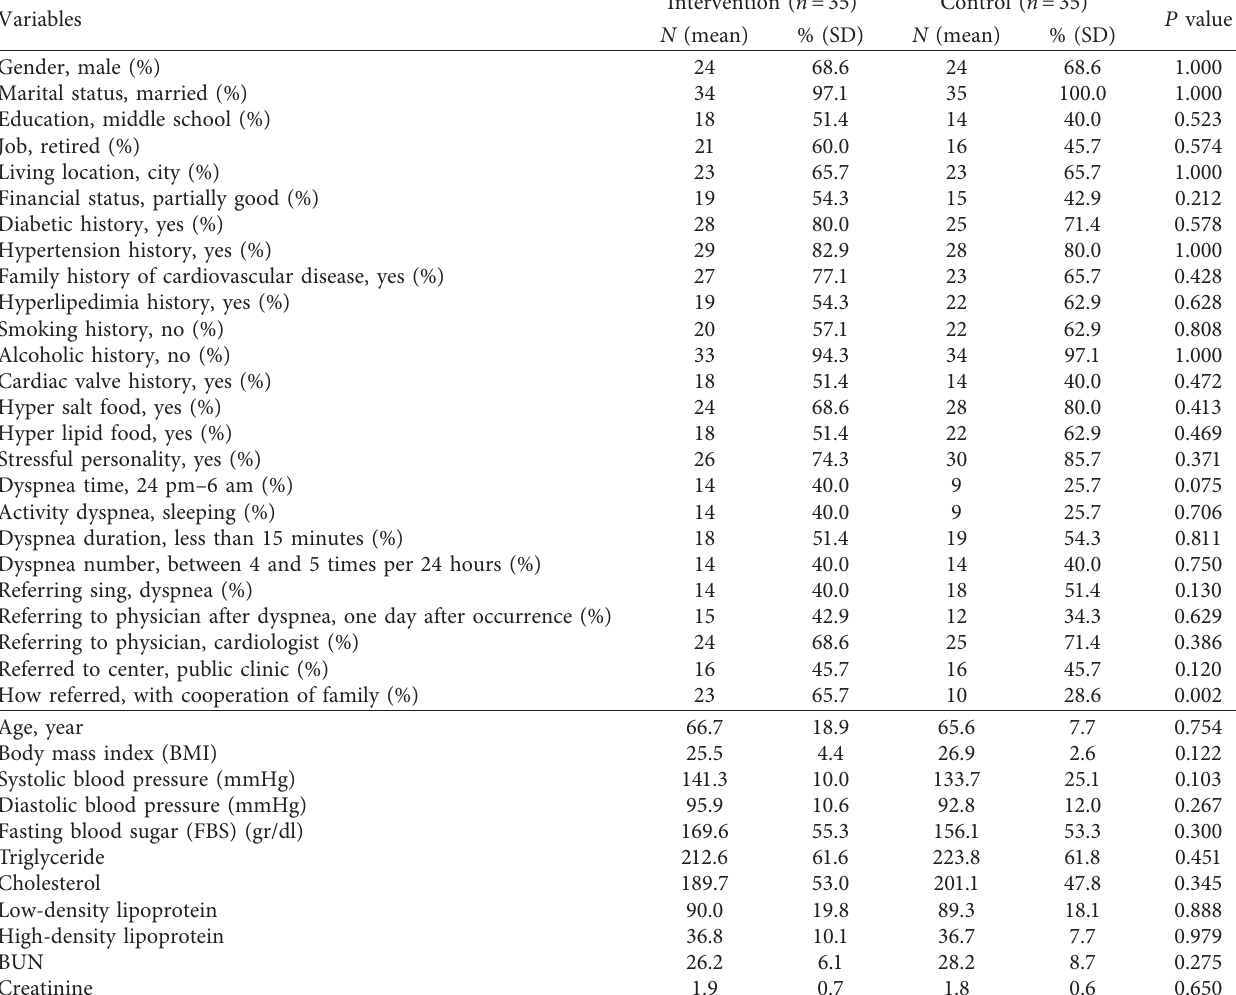
Table 1: Study participants’ characteristics in intervention and control